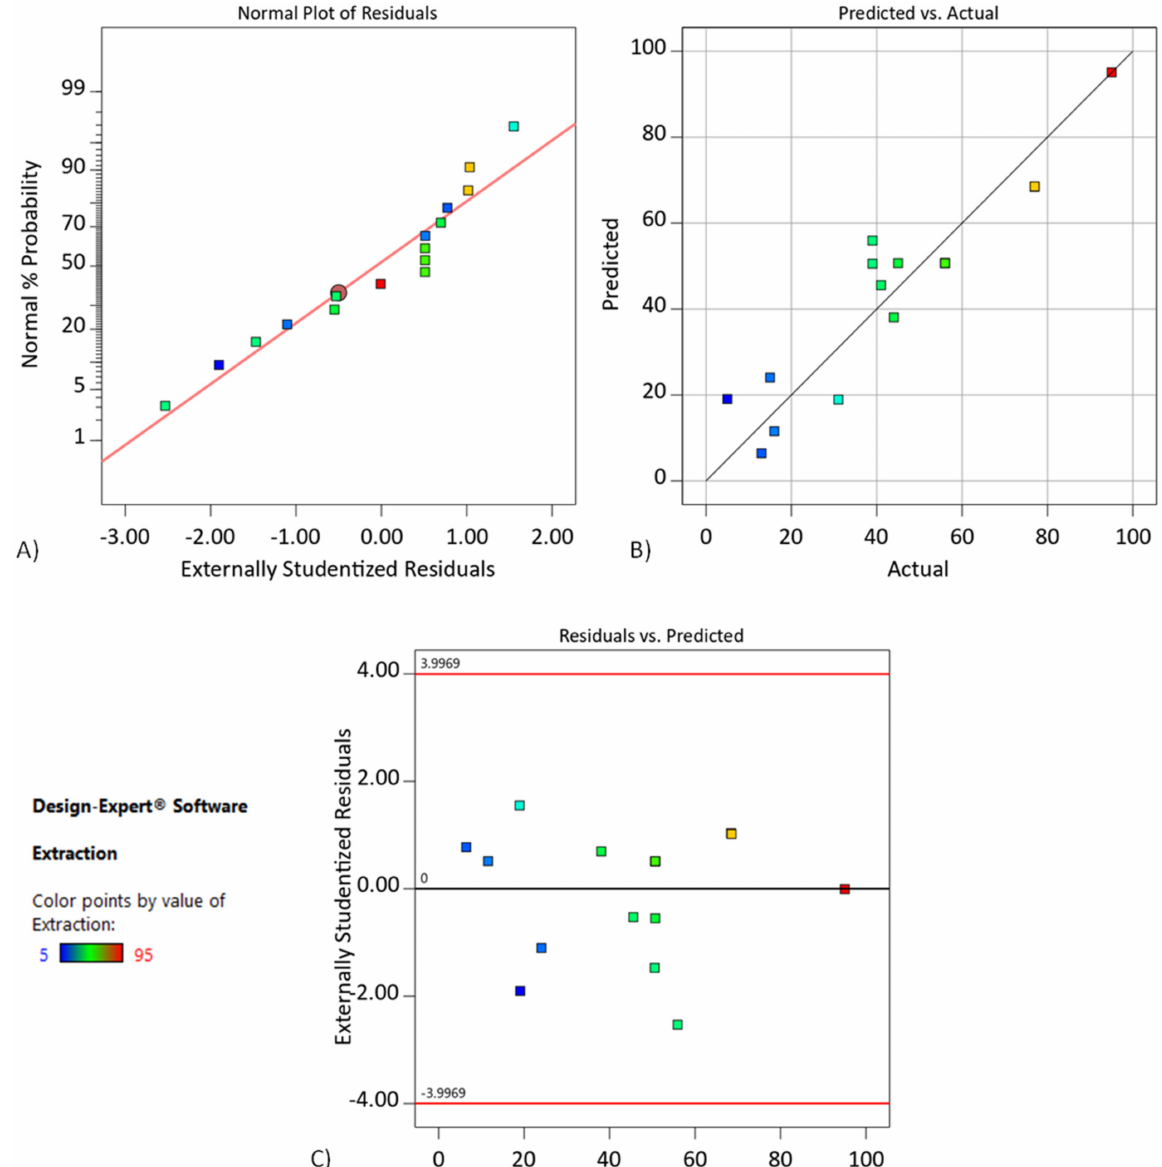
Figure 3. ( A ) The normal probability plot for chromium(III) extraction, ( B ) plot of observed values versus predicted values, and ( C ) plot of residuals versus observed values. DCSLM with threshold concentration of